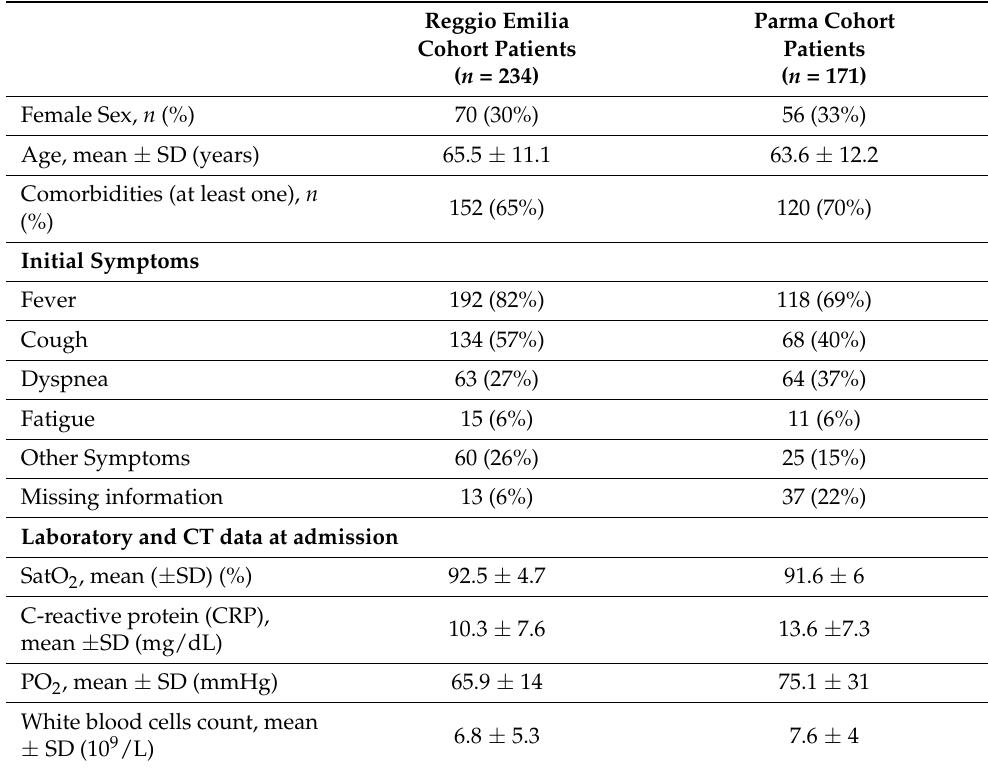
Figure 1. Flow chart depicting patient enrollment for the two study cohorts. Table 1. Demographic and clinical characteristics of the included patients for the two cohorts. Continuous data are expressed as mean ± SD or median (IQR, interquartile range). Categorical data are presented as numbers with percentages in parentheses.